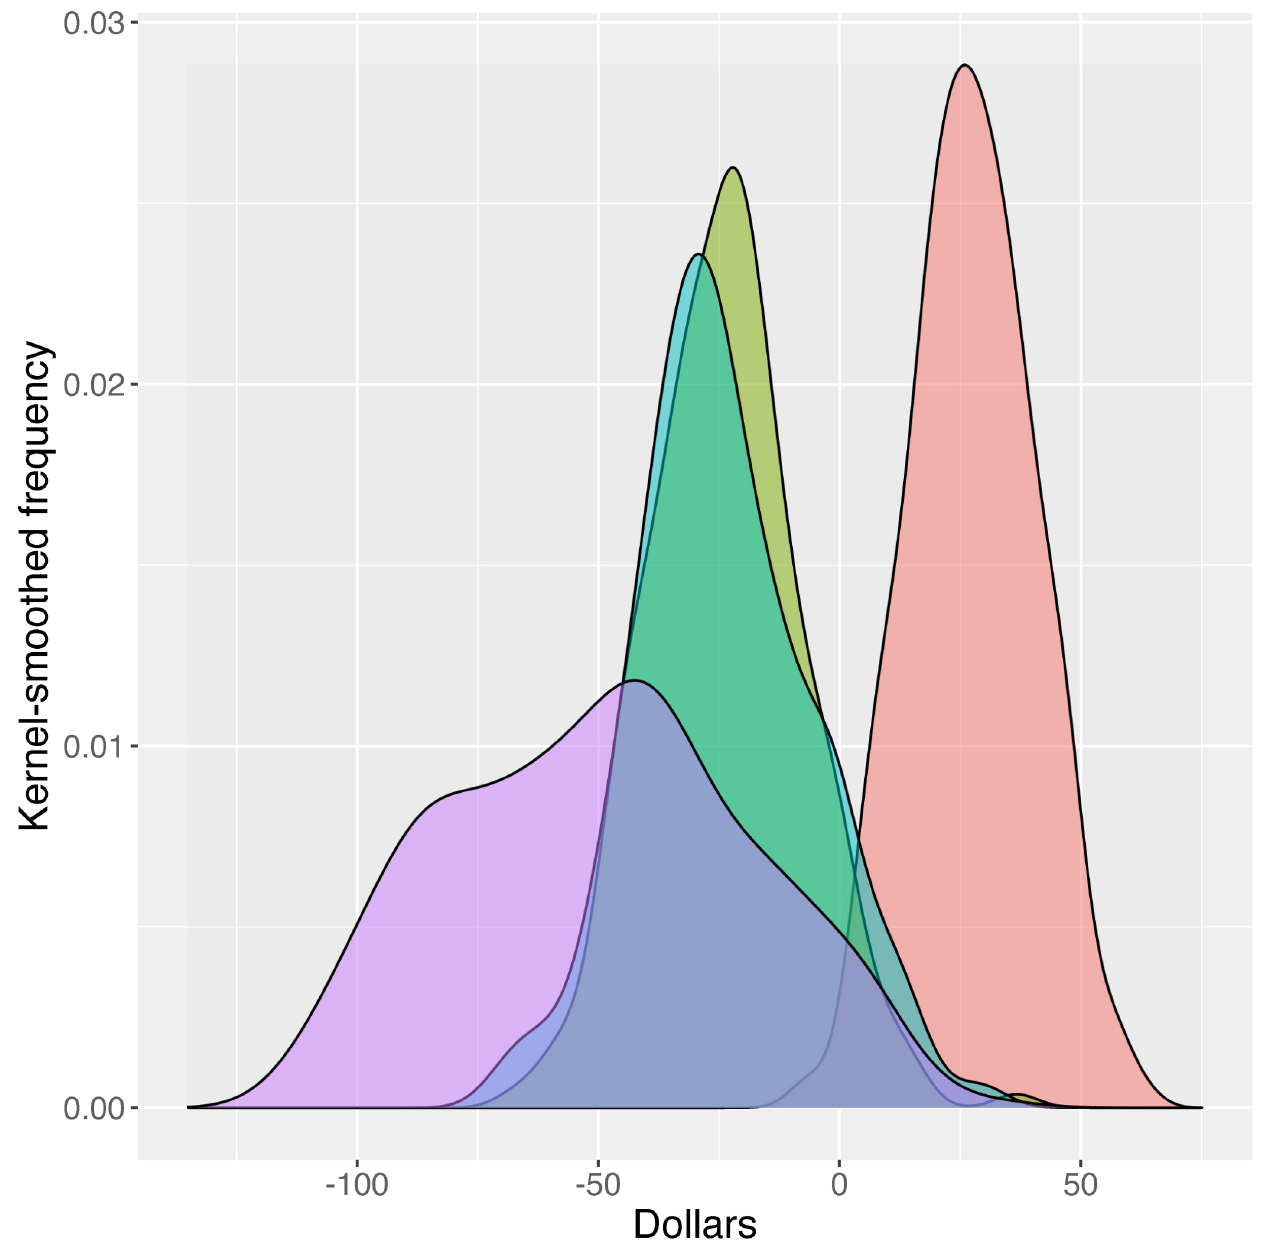
Fig 4. Mean willingness to pay for PrEP among 236 young men who have sex with men in the U.S.: Insurance options. Red: Insurance covered, compared to not covered. Green: Insurance covered, compared to not covered. Turquoise: Requires new insurance, compared to not covered. Purple: Insurance not private (services can be seen by family or employers), compared to